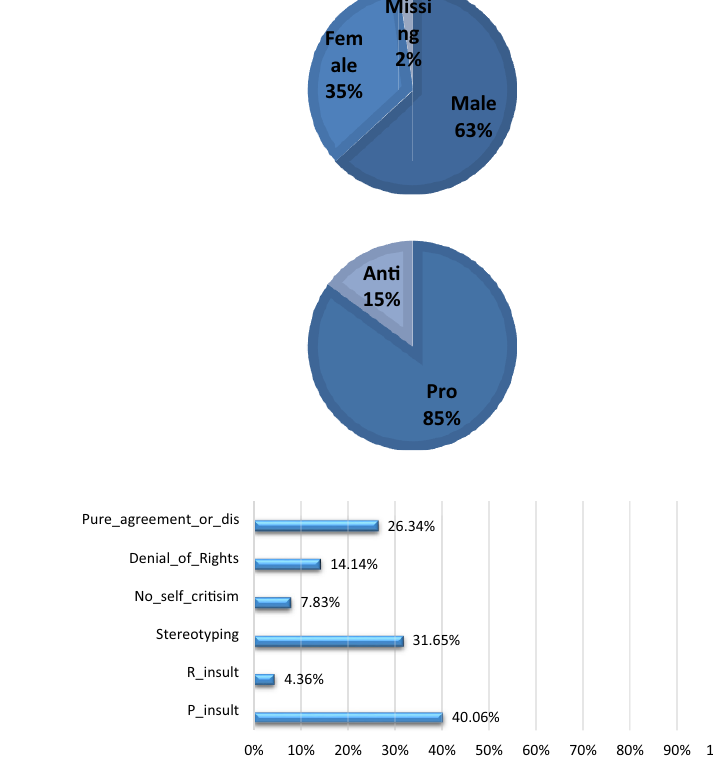
Figure 3. Gender distribution in the full dataset